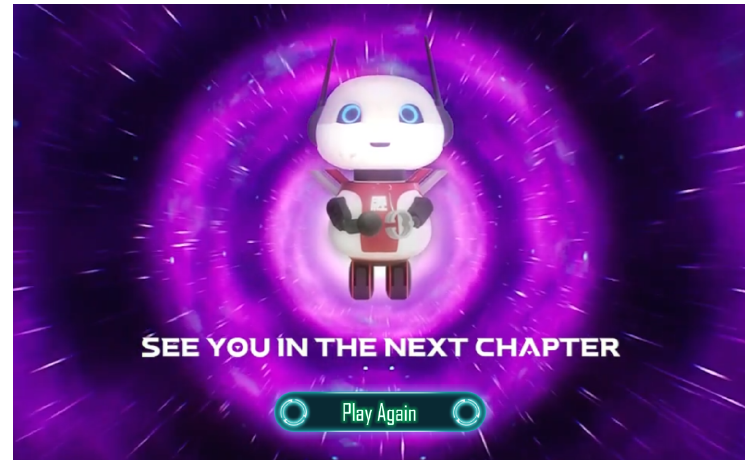
Figure A6. Final game animation.